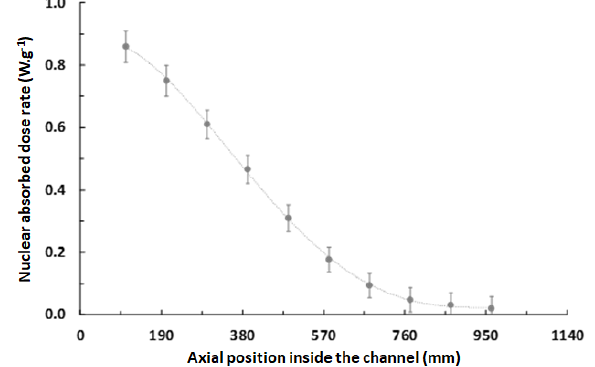
Fig. 3. Nuclear absorbed dose rate profile inside the H-IV A experimental channel of MARIA